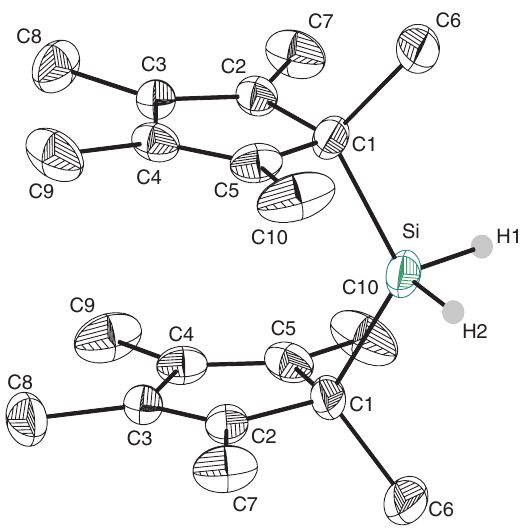
Figure 4: ORTEP at 40% probability and atom numbering scheme for compound E . Hydrogen atoms of the methyl groups are omitted for clarity. Hydro- gen atoms at the silicon are given in ball and stick type.